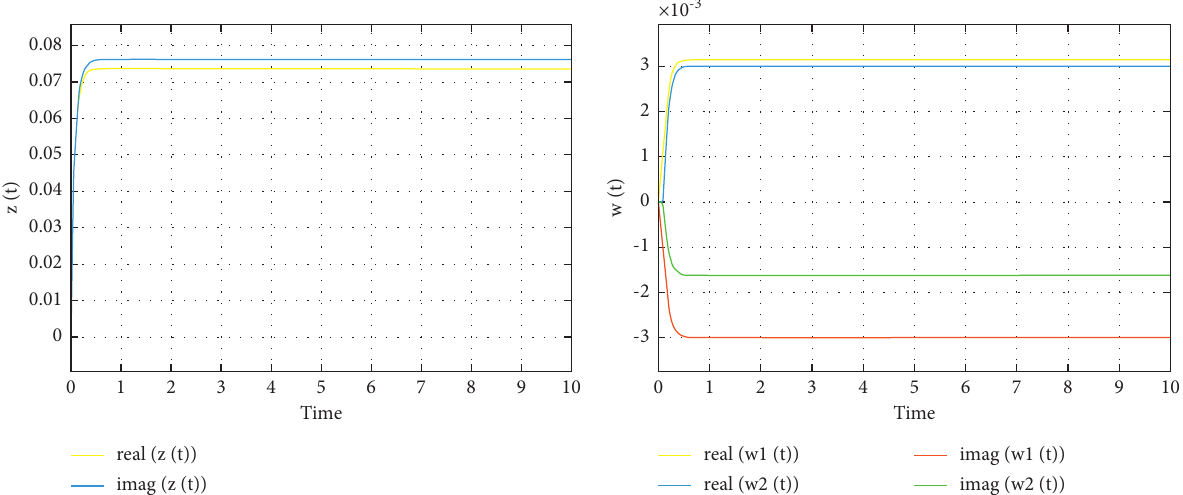
Figure 1: Curves of the real and imaginary parts of z ( t ) and w ( t ) in example 1.